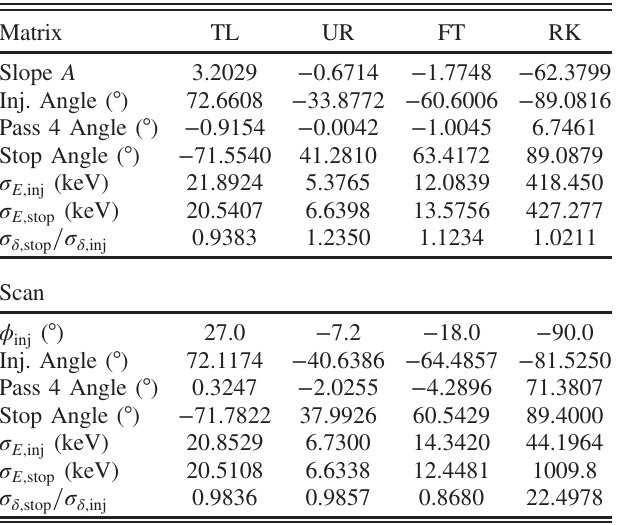
energy spread, found for a 1000-particle CBETA beam ( σ z ¼ 1 . 1 mm, σ δ ¼ 5 × 10 − 4 ) with matrices (top), or by scan- ning through phases of a UR injector (bottom). Angle describes the counter-clockwise angle between the positive z -axis in longitudinal phase space and a linear fit of the beam. The beam of order 10 − 3 in both coordinates is much larger than the z ¼ 10 − 7 m, δ ¼ 10 − 7 offset used to calculate the matrix, resulting in decreased accuracy for matrix tilted